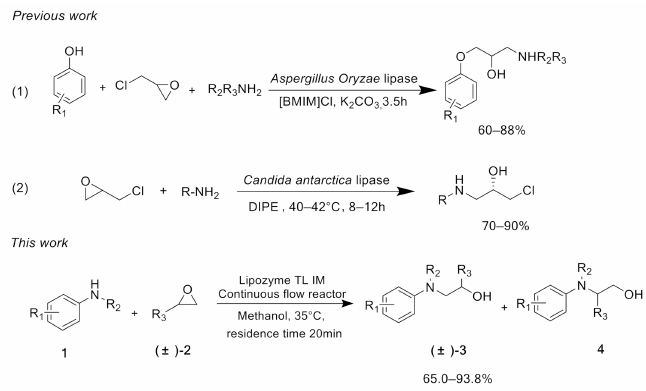
Figure 1. Examples of β -amino alcohol drugs.